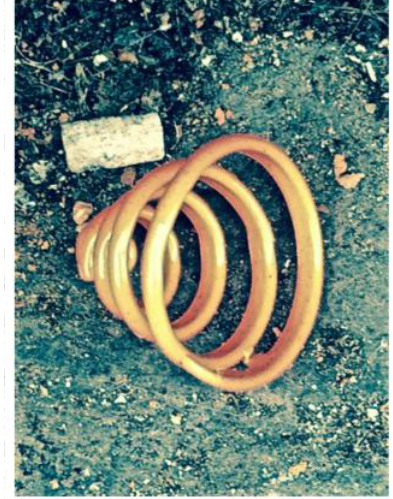
Figure 13. Plastic spiral on Car Park